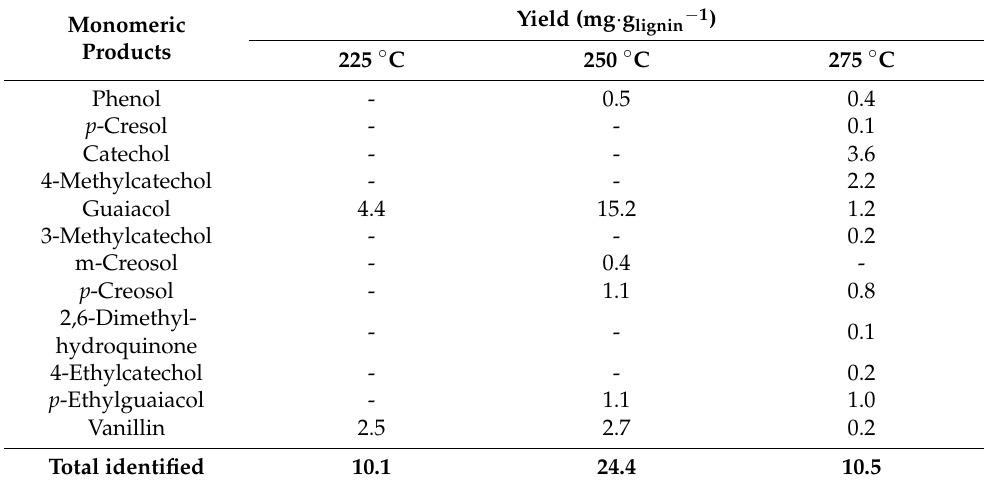
Table 2. Yield of monomeric products in the organic phase at different